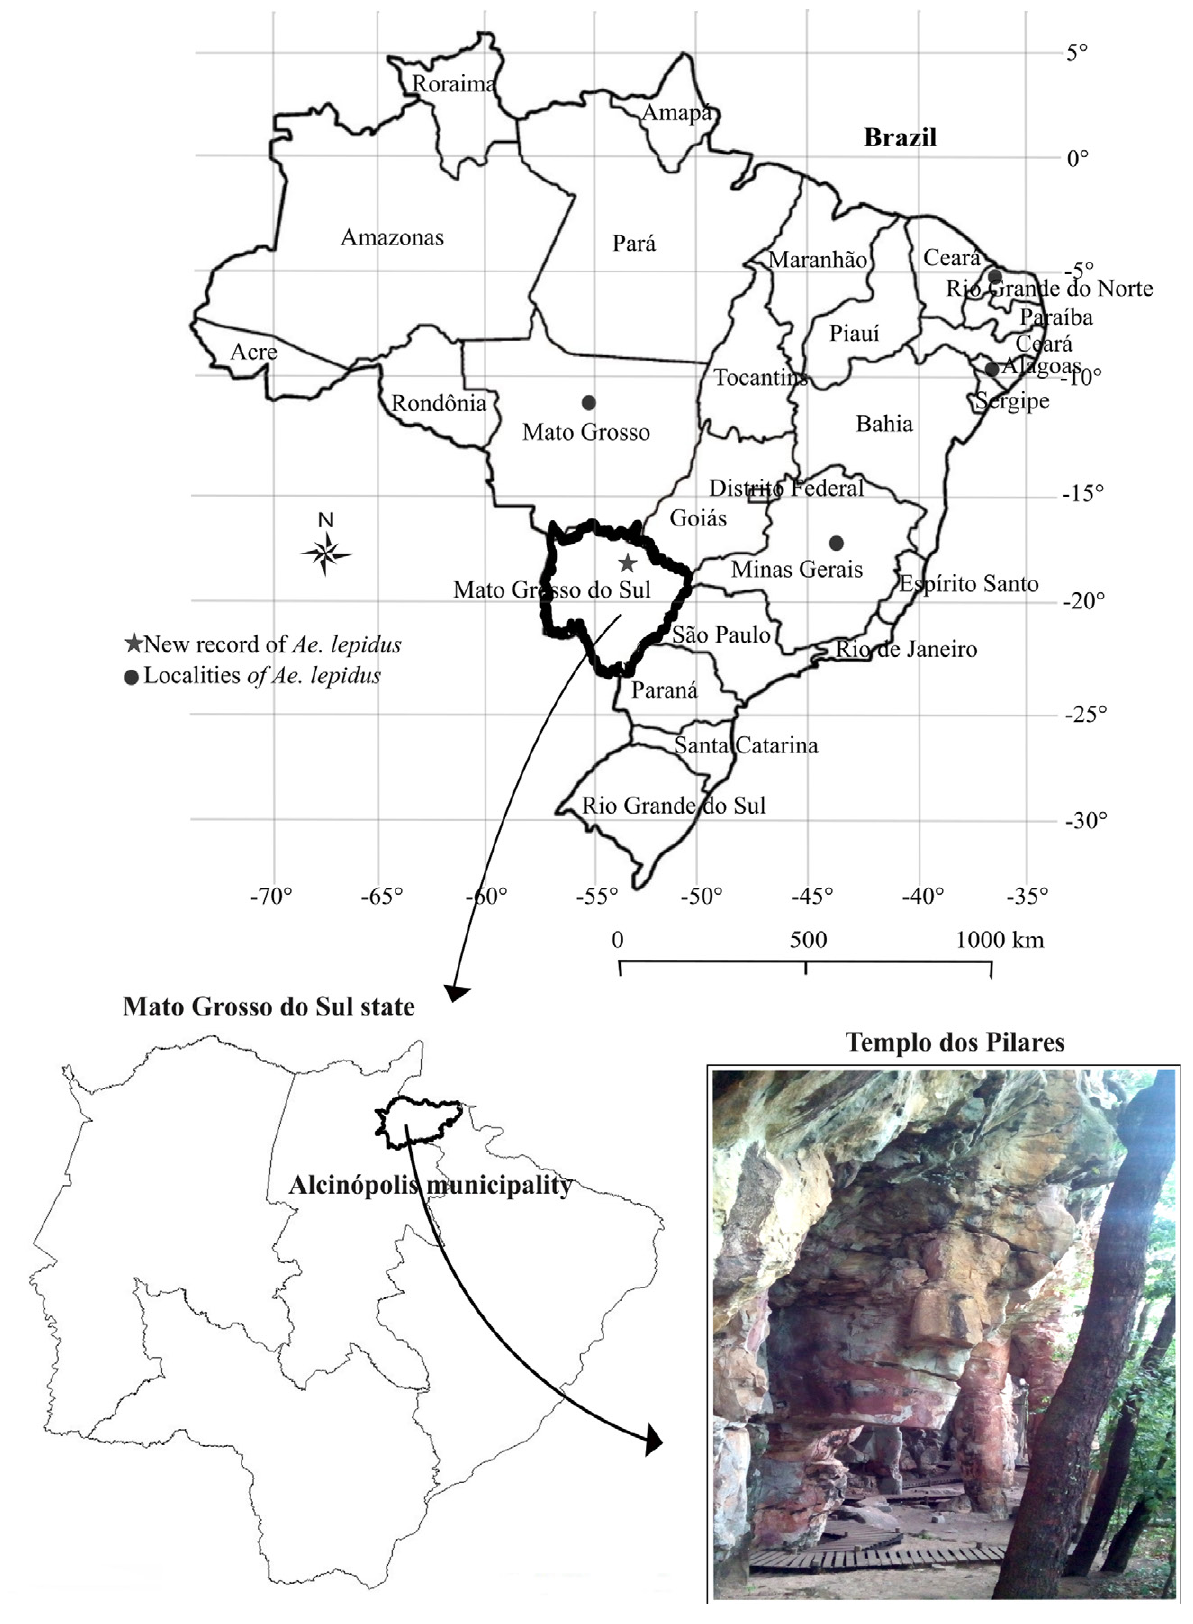
Figure 1. Geographical distribution of Aedes ( Ochlerotatus ) lepidus in Brazil. Entrance of Templo dos Pilares, Alcinópolis, Mato Grosso do Sul state, Brazil. Photo: Templo dos Pilares by Andreia Fernandes